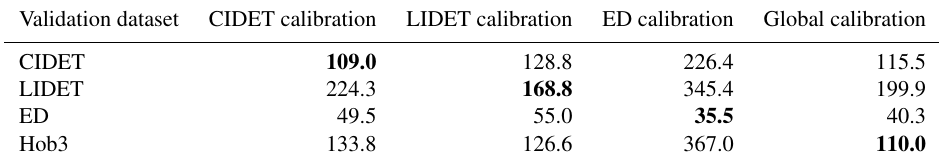
Table 3. The RMSE values for the different validation datasets when the model is run with the MAP values from the calibrations done with the different datasets. As with the measurements, the RMSE unit here is grams. The lowest RMSE for a particular dataset is bolded.